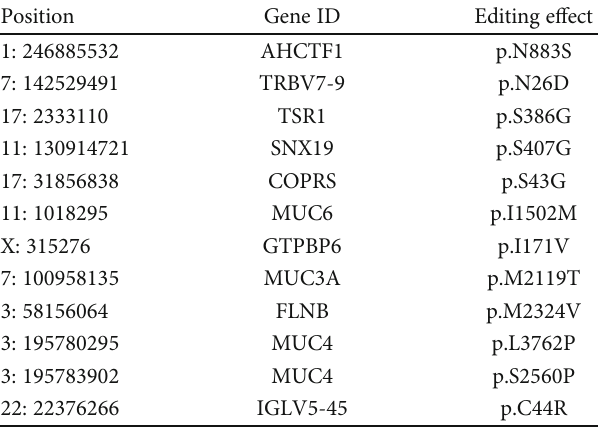
Figure 10: Association between the number of editing sites and (a) length of the chromosome, (b) number of Alu elements, and (c) number of protein coding genes. Table 3: List of novel editing sites with nonsynonymous